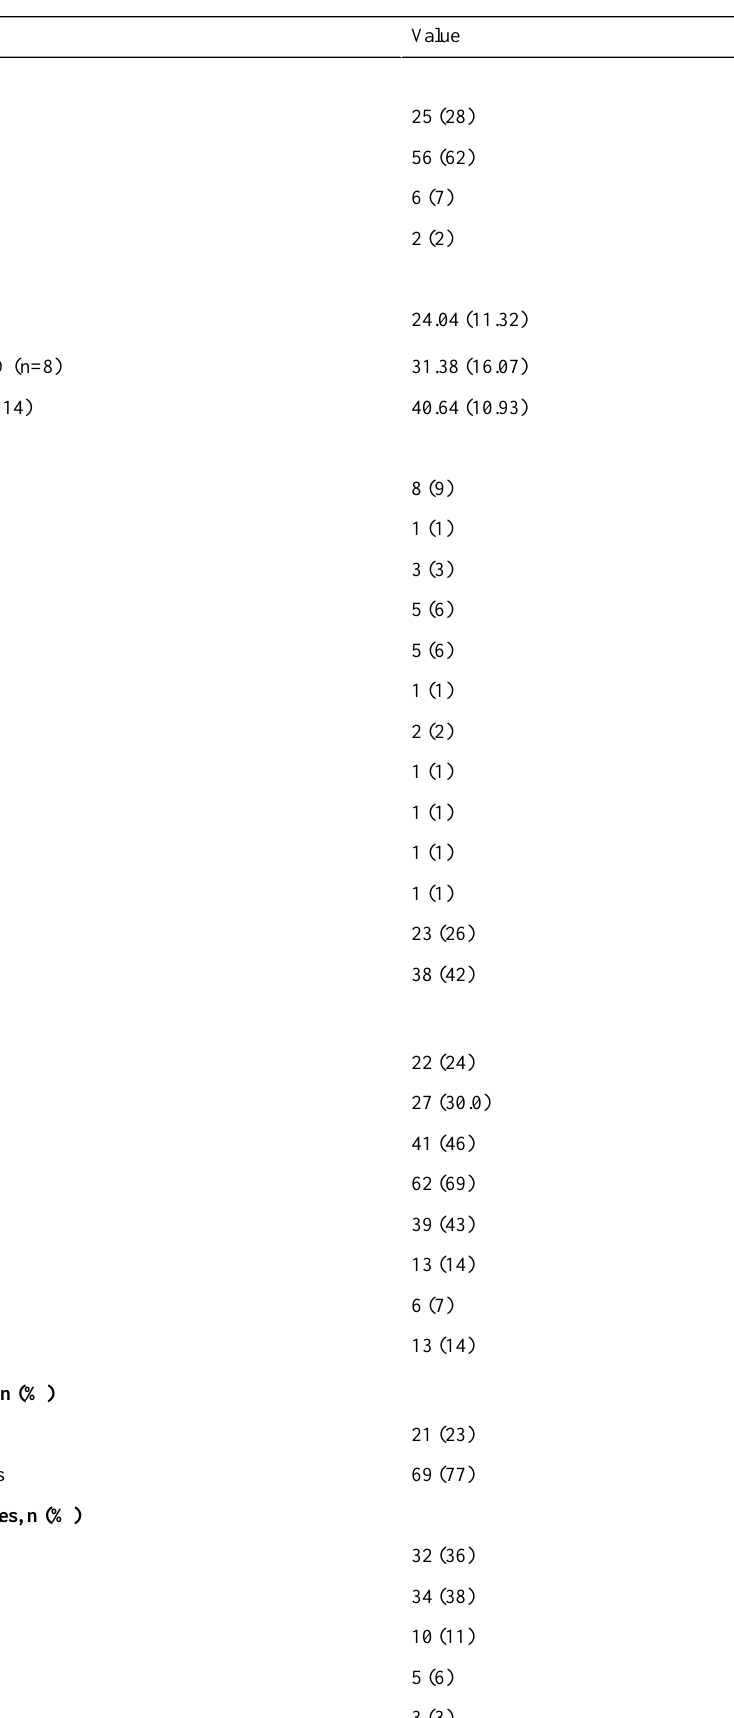
Table 1. Demographic composition of sample